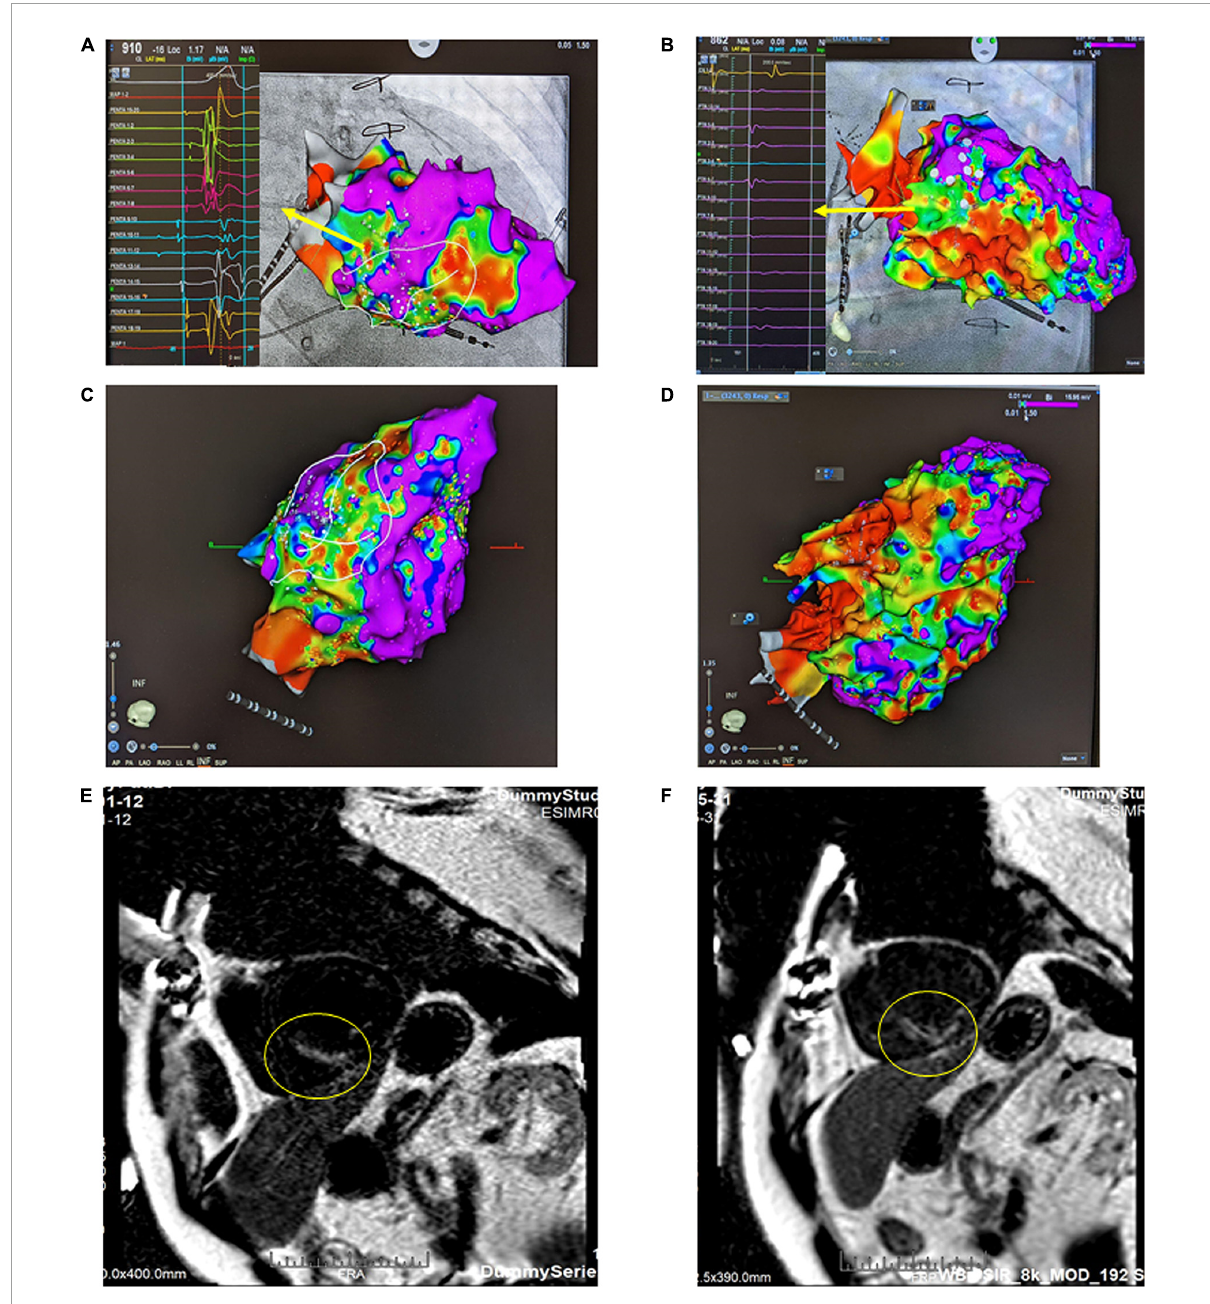
FIGURE2 Bipolar voltage mapping with a 3D CARTO mapping system (Biosense, Diamond Bar, CA). (A) The presence of a large, uneven, mixed scar and viable zone in the area of the left ventricular basal to the middle posteroseptal wall from the right anterior oblique (RAO) view. The arrow indicates LAVA, the substrate, as the target ablation zone. (B) After SBRT, the therapy zone became a scar zone. The arrow indicates local voltage < 0.5 mV. (C) Inferior view of the left ventricle (LV) before SARS. (D) Inferior view of the left ventricle (LV) after SBRT. (E) Cardiac MRI using a wide-band sequence before SBRT. A delay in the enhancement of the mid-basal septal wall and mid-inferior wall was noted, which indicated scar formation in this area. (F) Cardiac MRI after SBRT. The previously shown delay in enhancement of the mid-basal septal wall and mid inferior wall was still present; however, the affected area was slightly larger than that on the previous MRI.